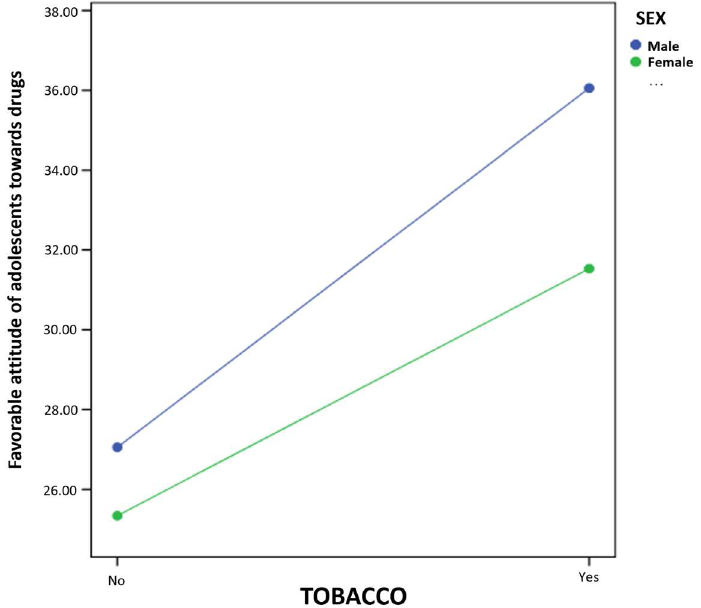
Figure 2. Interaction of tobacco use and sex in the prediction of favorable attitude toward drugs in adolescents.